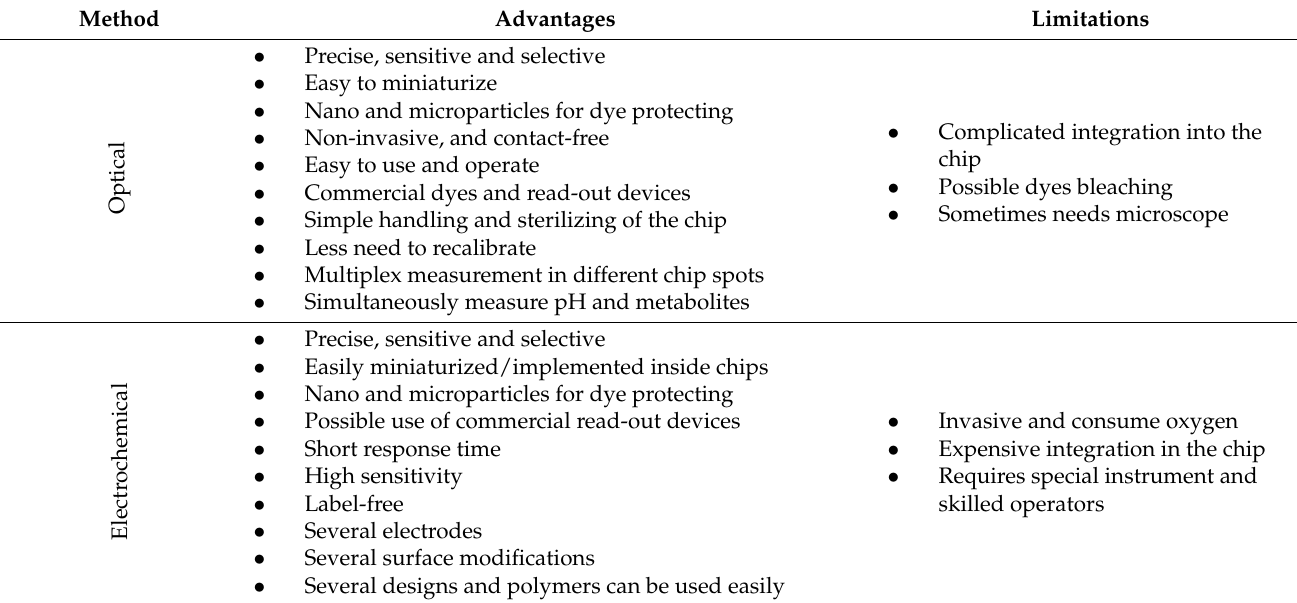
Table 1. Comparison of chip-based electrochemical and optical O 2